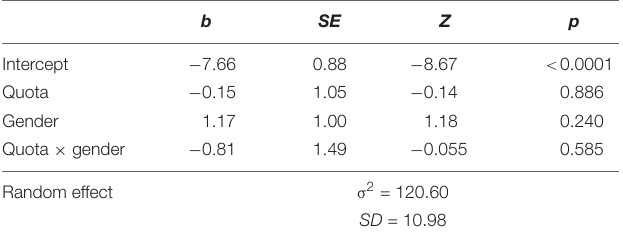
TABLE 4 | Multilevel binomial logistic regression on the odds of emotional vs. not emotional